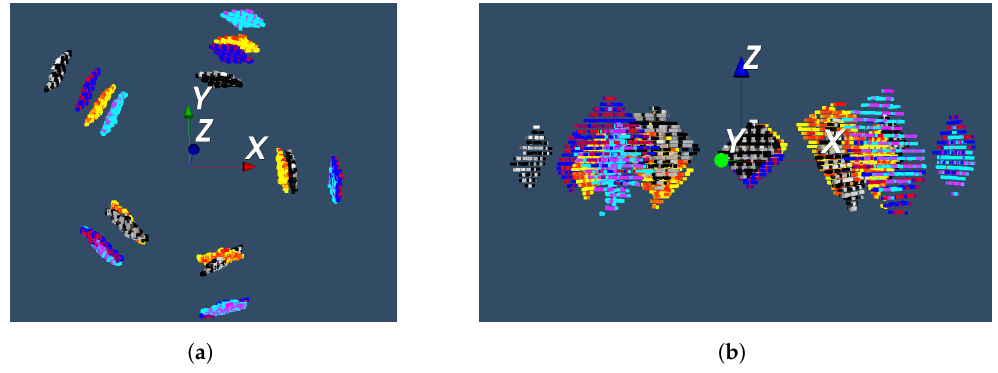
Figure 10. Distribution of the 20 chessboard positions. The chessboard is captured by the LiDAR from different heights and angles. The length of the coordinate axis is 1 m. Four groups of colors represent four positions of the chessboard for each horizontal camera. ( a ) Top view of the point clouds of the chessboard; ( b ) Side view of the point clouds of the